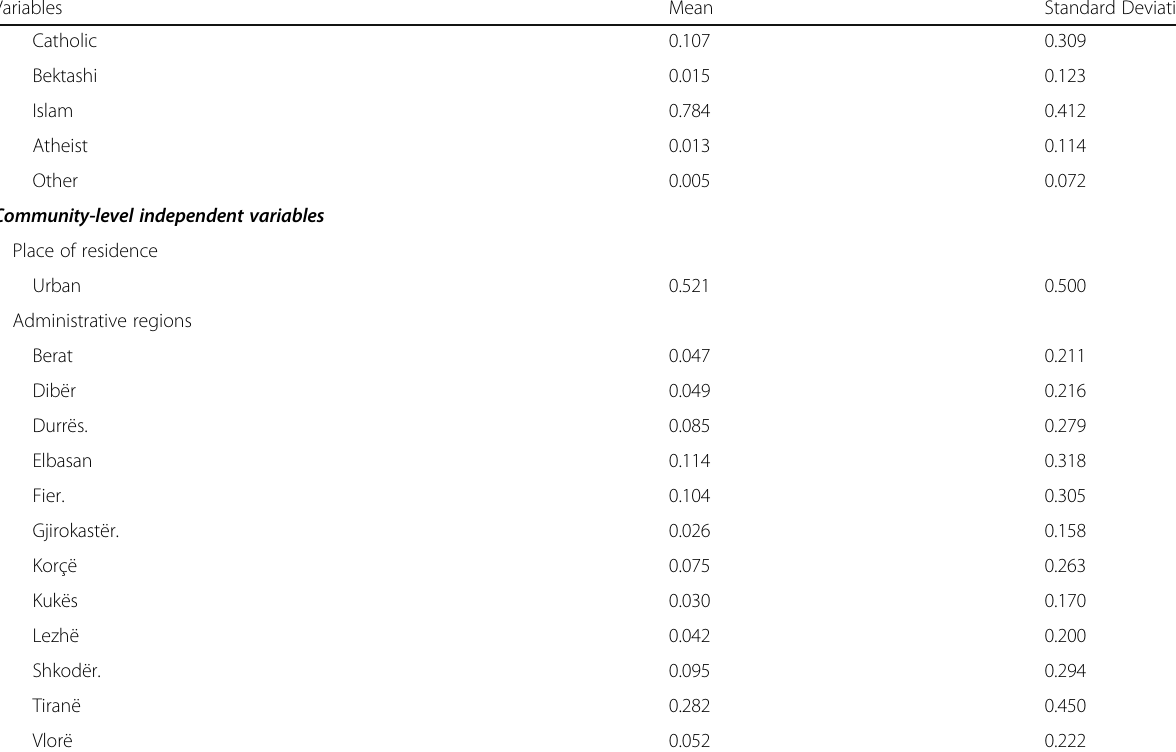
Table 1 Summary Statistics for the dependent and independent variables ( N = 25,986) (Continued)